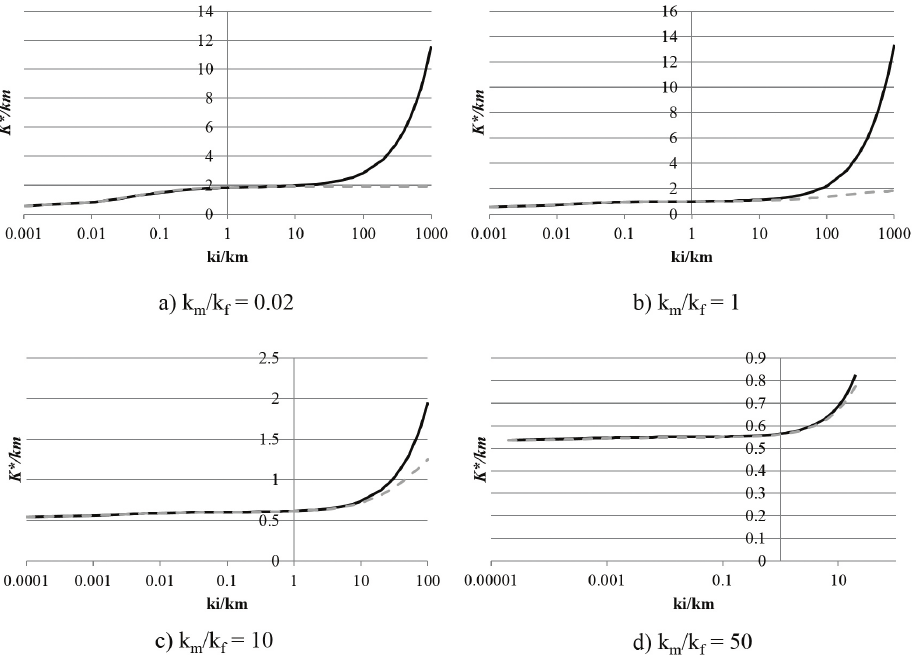
Figure 11. Effective thermal conductivity versus interphase thermal conductivity for imperfect/perfect interfaces and v lines - imperfect interfaces; dashed lines - perfect interfaces).